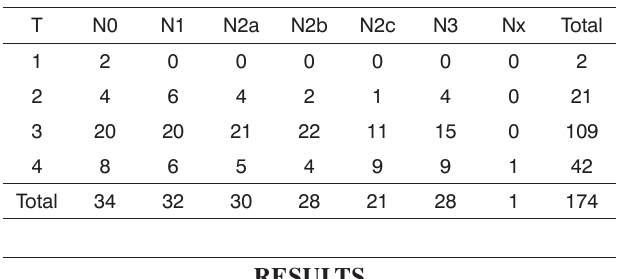
Table 1. Distribution of patients according to T and N staging.